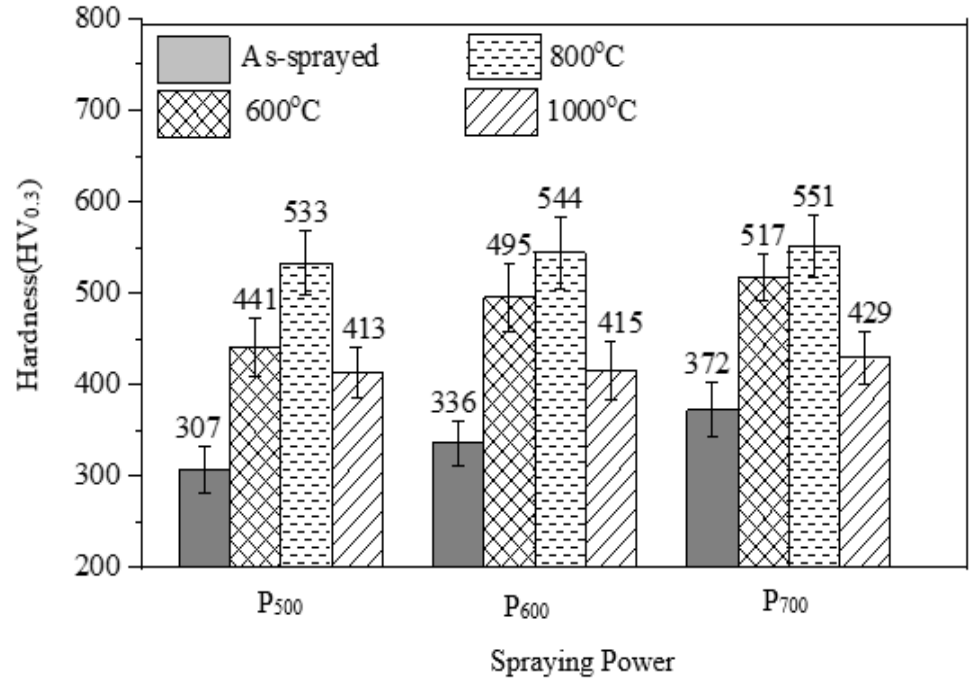
Figure 8. Average hardness of the as ‐ sprayed and heat ‐ treated coatings at 600 °C, 800 °C and 1000